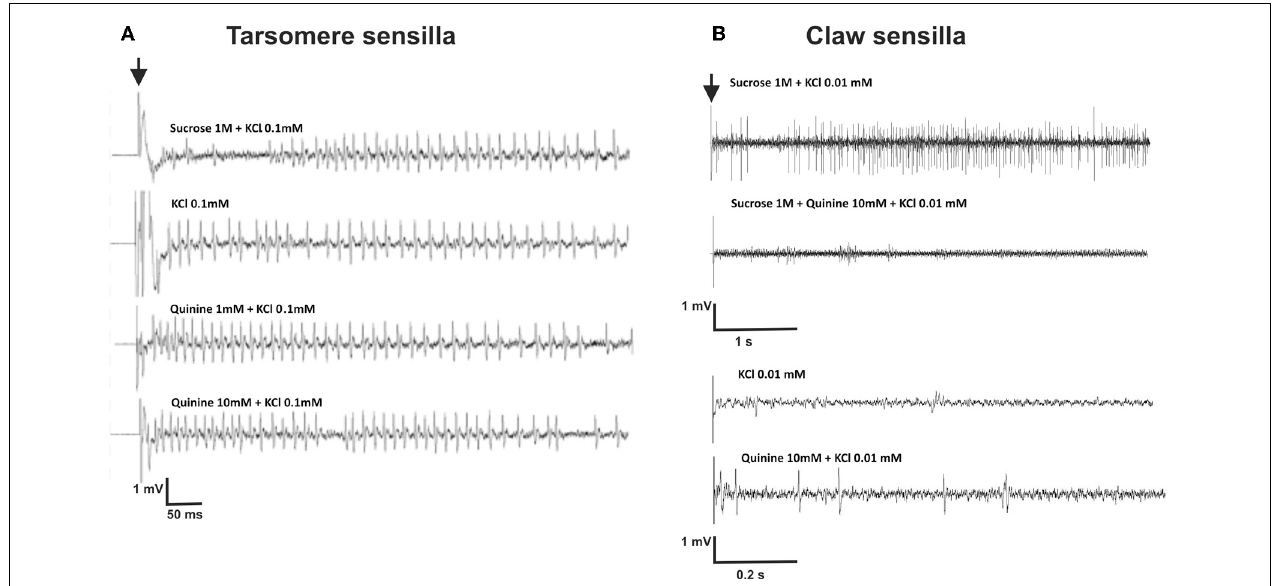
FIGURE 5 | (A) Experiment 3: Examples of extracellular recordings performed at the level of chaetic sensilla located on the third and fourth tarsomeres of the foreleg, upon 2-s gustatory stimulation. The contact electrolyte used for all solutions was KCl 0.1mM. The black